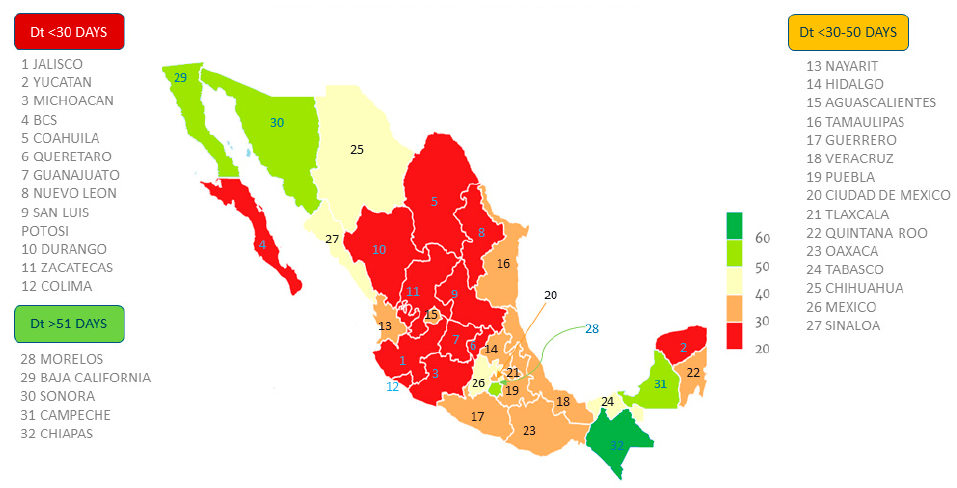
Figure 2. Mapping doubling time in Mexico. Note: Doubling time (Dt) average of the COVID-19 cases during epidemiological weeks 13–26 for each Mexican